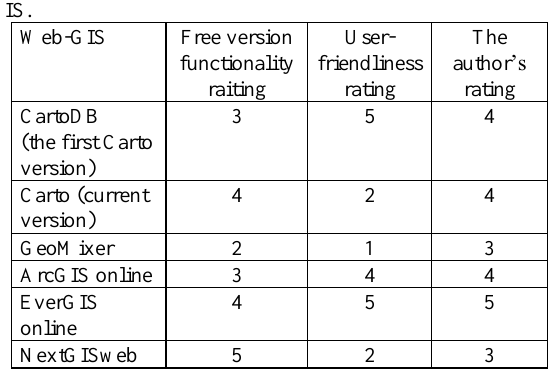
Table 2. An integrated assessment of the used GIS.